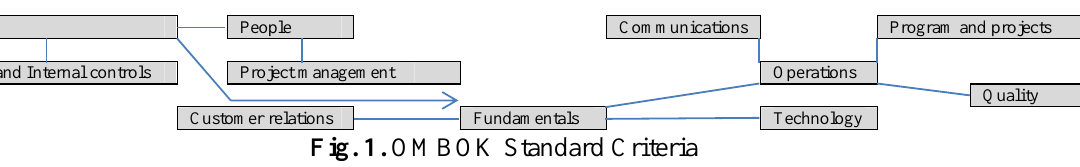
Fig. 1. OMBOK Standard Criteria